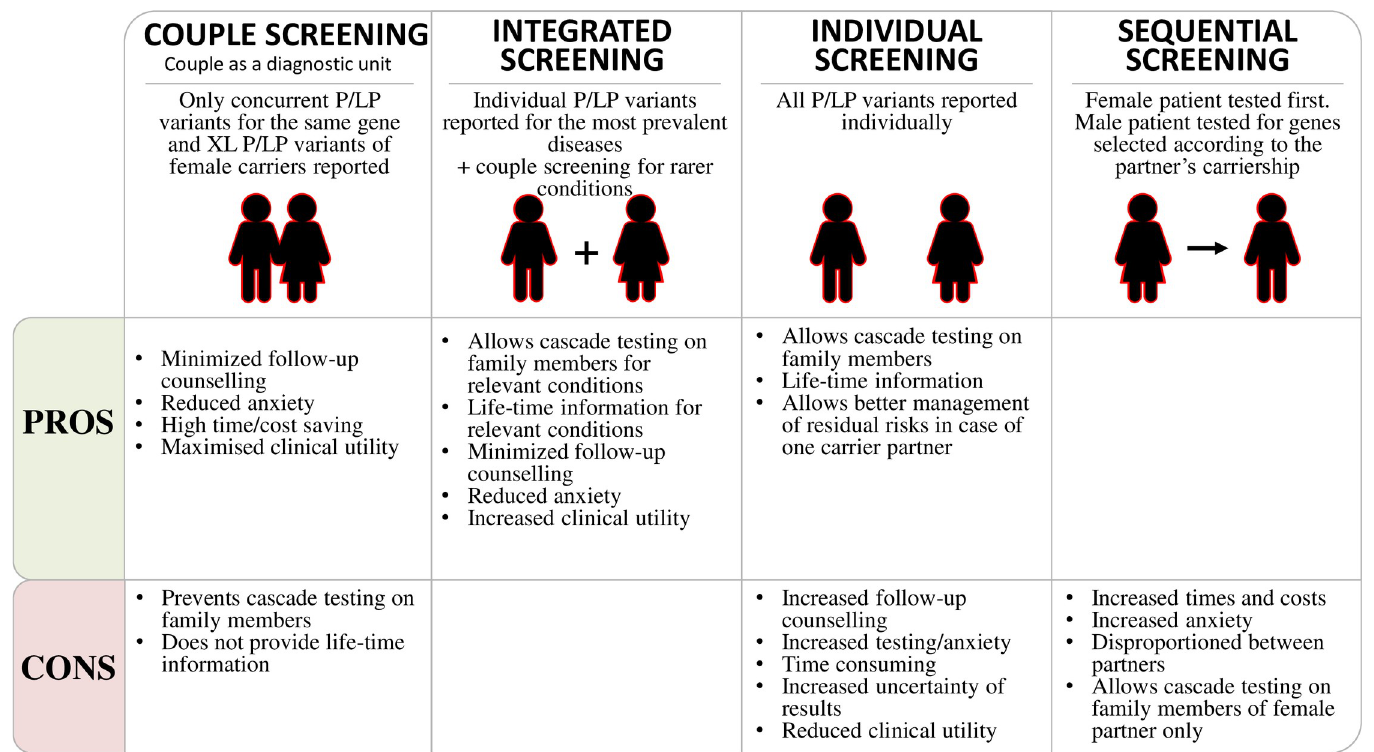
Fig 4. Preconception carrier screening strategies when exome sequencing is used for genetic analysis.